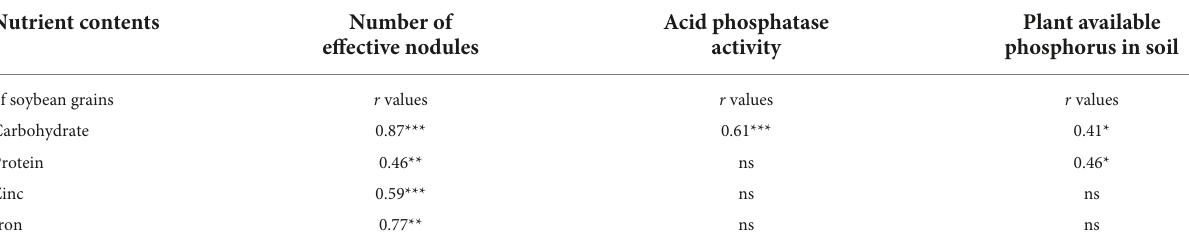
TABLE 4 Correlation of nutrient value of soybean grains with the number of effective root nodules, acid phosphatase activity in the rhizosphere, and plant available phosphorus in